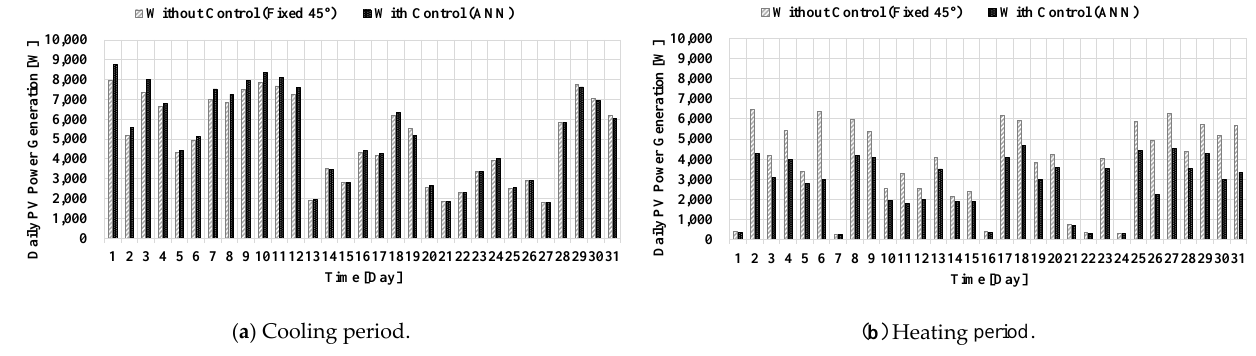
( a ) Cooling period. Figure 17. PV power generation with and without ANN optimal control.